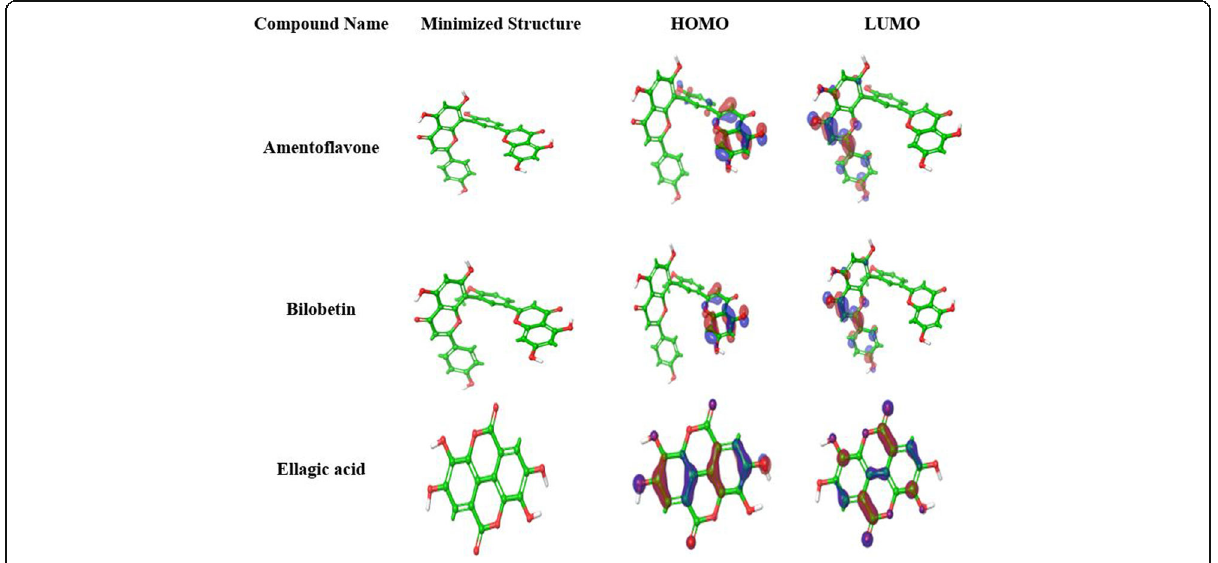
Fig. 4 The HOMO and LUMO occupation for the selected compounds. Blue and red are positive and negative in its wave